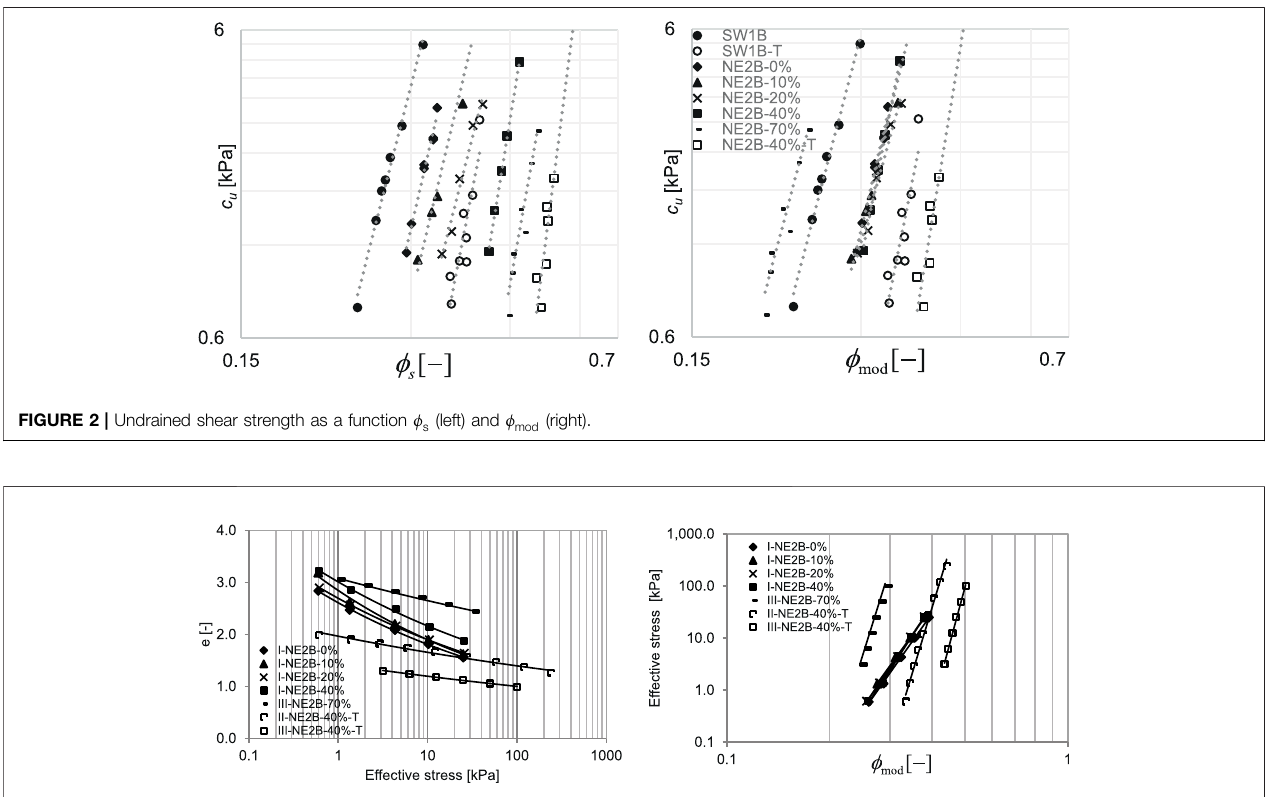
FIGURE 3 | Left: log effective stress – void ratio (e) graph. Right: Effective stress as a function of ϕ mod for the IL tests.